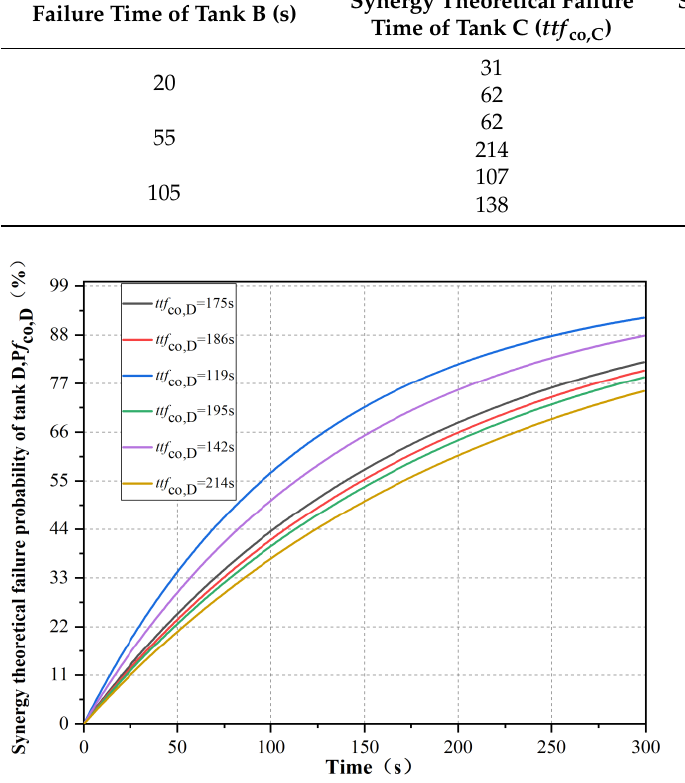
Figure 11. Real-time failure probability of tank D under the synergistic effect of tanks A and B and tanks A, B and C.